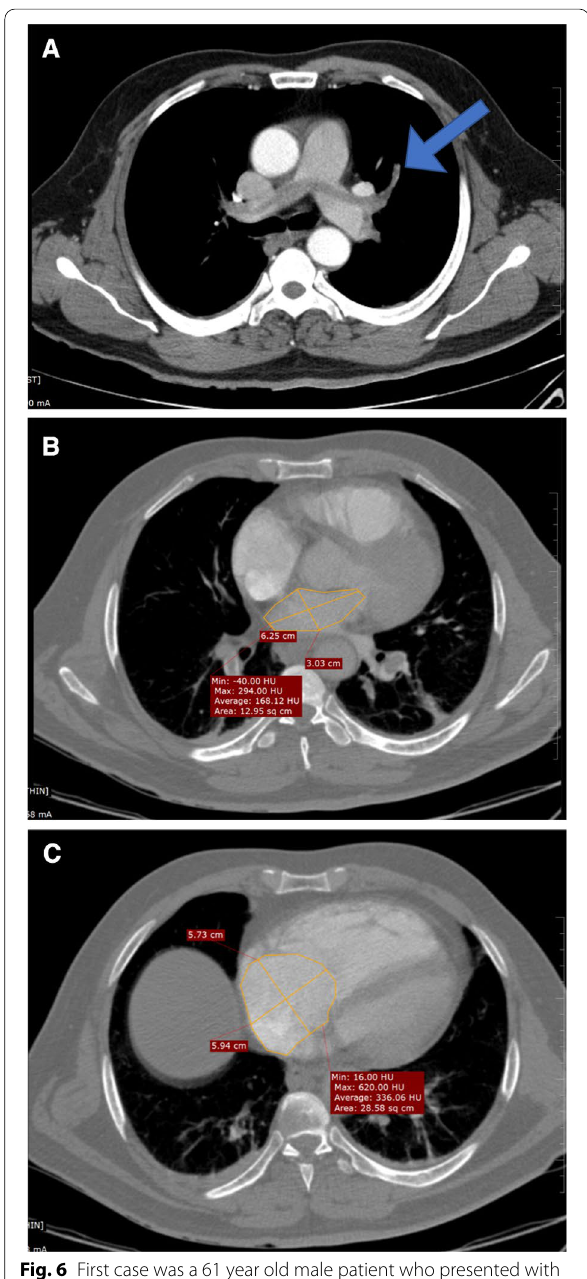
Fig. 6 First case was a 61 year old male patient who presented with history of breathlessness since 1 week and an elevated d- Dimer level of 8.9 µg FEU/ml. a CTPA showing saddle-shaped thrombus in the bilateral pulmonary arteries. b CTPA – Left atrial parameters. c CTPA – Right atrial parameters